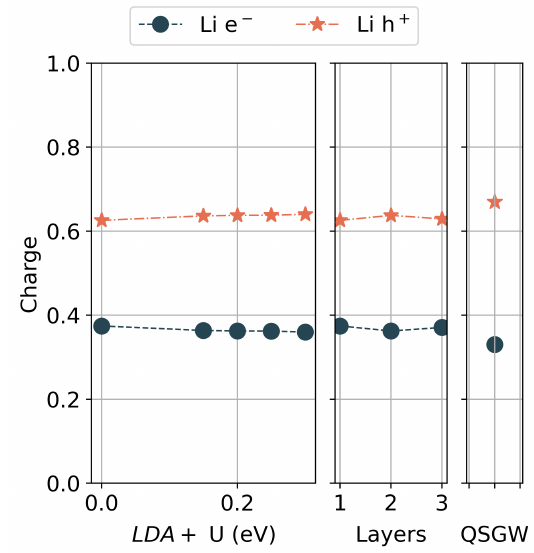
Figure 9: Electron and hole (1-electron) charge on Li atom for (a) various values of U at LDA + U theory (b) LDA for various number of layers (c)